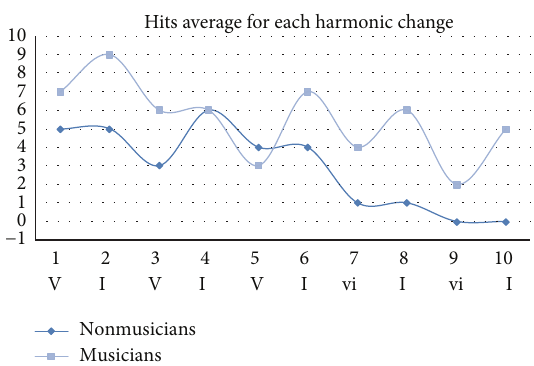
Table 4: Table of complete and partially successful harmonization over 11 subjects. The partial harmonization happens when the subject succeeds in harmonizing only the first 7 units of the song, involving only the tonic and dominant chords. These subjects failed to identify and/or to find the vi-degree minor parallel chord. Complete harm. 1